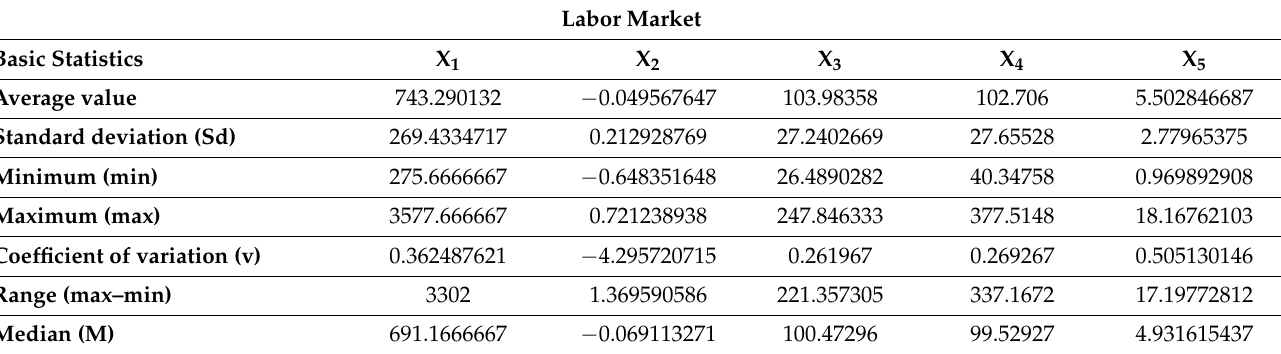
Table 2. Main characteristics of empirical features describing the human capital in area of labor